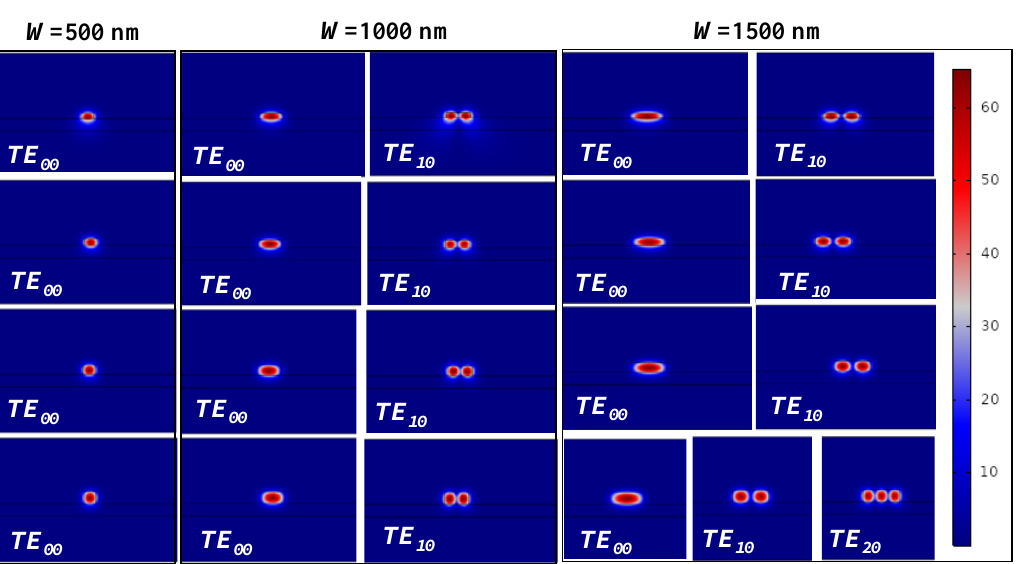
Figure 7. Re( n eff ) versus W for the H of ( a ) 200 nm, ( b ) 300 nm, ( c ) 400 nm and ( d ) 500 nm. Please note that only the TE- fundamental mode was considered.